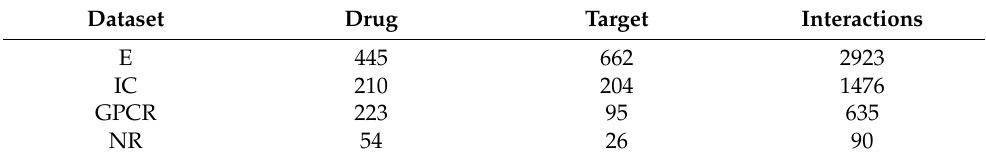
Table 1. Statistics on the number of drugs and targets in the standard dataset. There are four subsets: enzymes (E), ion channels (IC), G protein-coupled receptors (GPCR), and nuclear receptors